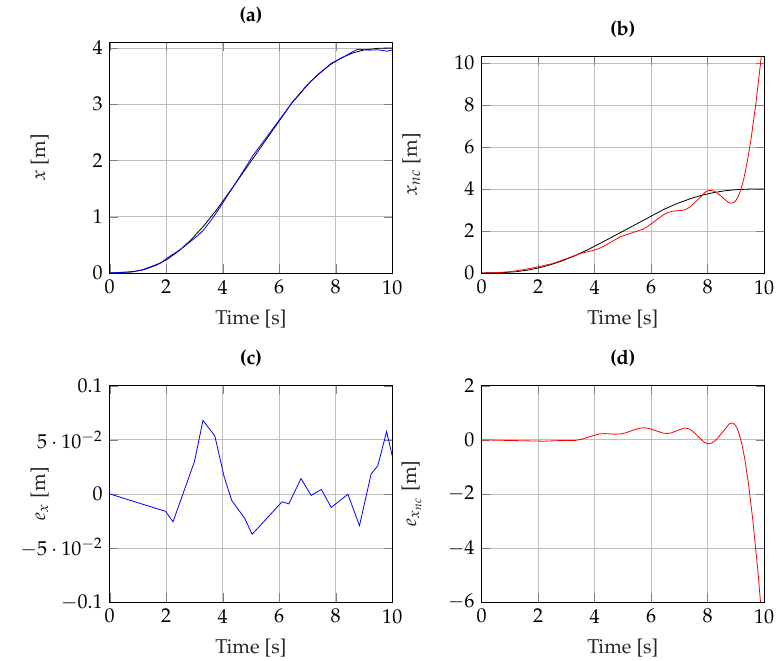
Figure 5. ( a ) Longitudinal motion of the UAV: the reference x ref (black), x with robust control (blue); ( b ) Longitudinal motion of the UAV: the reference x ref (black), x nc with non-robust control (red); ( c ) Longitudinal error motion of the UAV with robust control e x (blue); ( d ) Longitudinal error motion of the UAV with non-robust control e x (red). nc